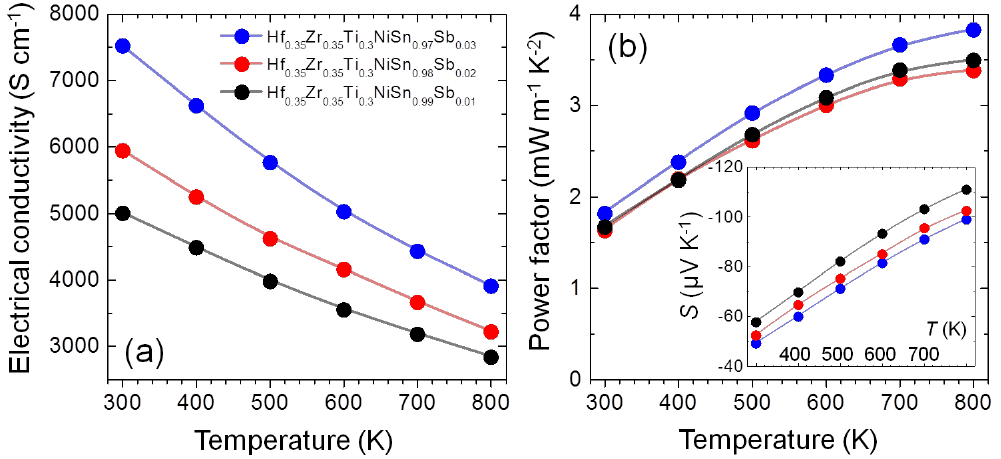
Figure 3. Temperature dependence of ( a ) electrical conductivity and ( b ) power factor for SPSed bulks of Hf 0.35 Zr 0.35 Ti 0.3 NiSn 1 − x Sb x ( x = 0, 0.01, 0.02, 0.03). Inset of (b) is the temperature-dependent Seebeck coefficient.